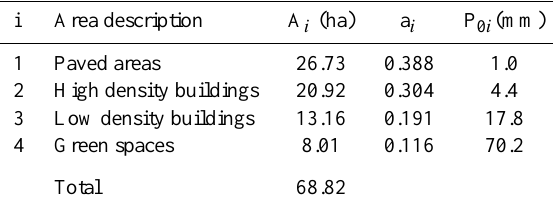
Table 1. Pio XII urban catchment